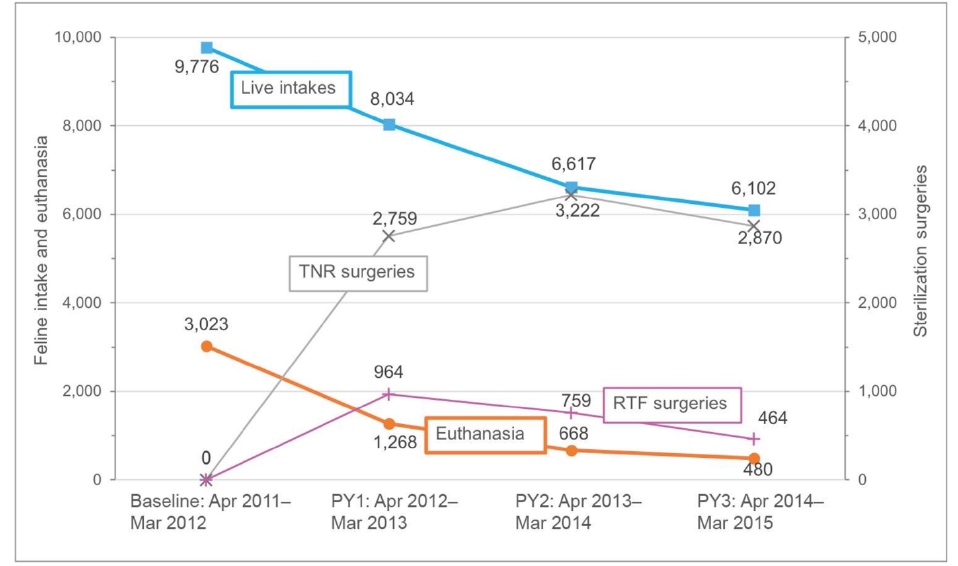
Figure 1. Feline intake, euthanasia, and surgeries: Albuquerque community cat program